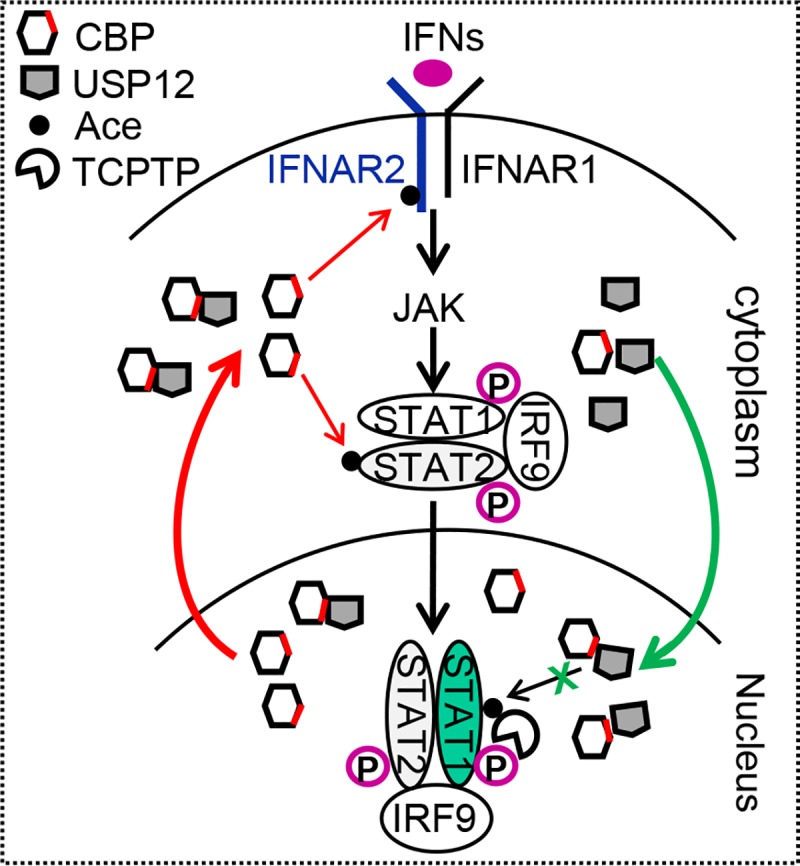
A proposed model of regulation of the IFN-JAK/STAT1 signaling by USP12.USP12 translocates from cytoplasm to nucleus in IFN signaling. The decrease in cytoplasmic USP12 levels facilitates CBP-mediated acetylation and activation of IFN signaling. USP12 accumulation in the nucleus maintains activated p-STAT1 levels by blocking CBP-mediated acetylation of p-STAT1 and subsequent TCPTP-mediated dephosphorylation of p-STAT1, which enables efficient IFN antiviral response.